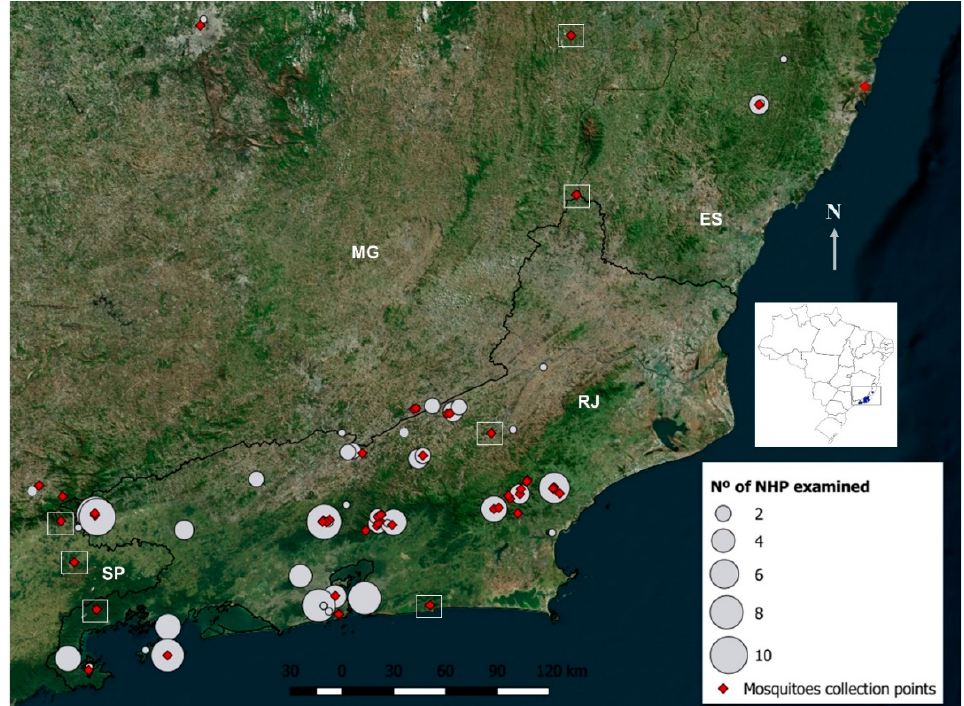
Figure 2. Satellite image showing mosquito and non-human primate (NHP) collection points. The number of NHPs captured is proportional to the size of the circle. Empty squares indicate areas where we attempt to capture NHPs without